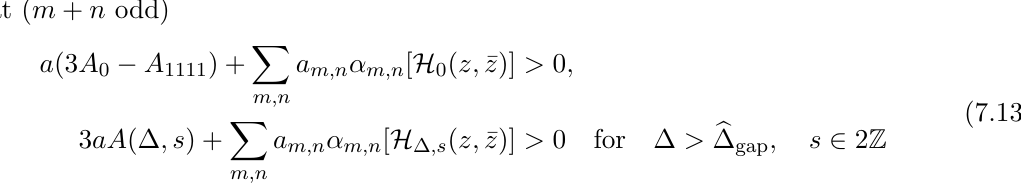
Figure 5 . The integration region (cid:28) -plane. The entire region enclosed by the solid line is D 0 . The region between the solid and dashed lines is D 0 D 1 , and the shaded region is its image E under z n z 1 =z for the left half. The entire unshaded region inside solid line is the integration region ! See appendix